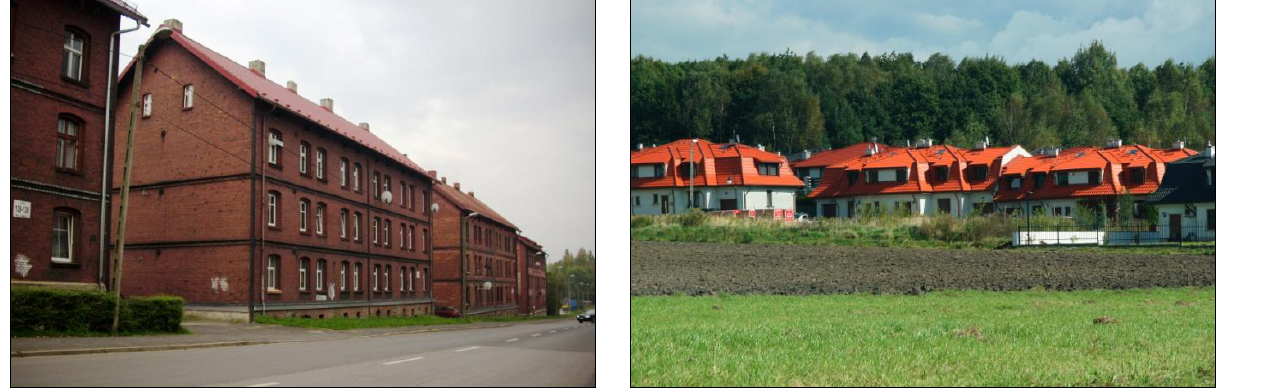
Fig. 7. Tenement houses in the Kochłowice district ( K. Mazurek )